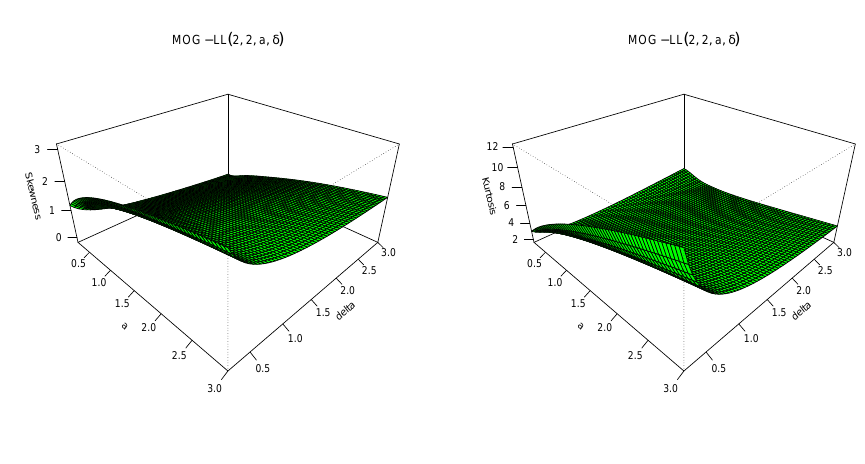
Figure 3 – Skewness (left panel) and Kurtosis (right panel) of MOG-W distribution.